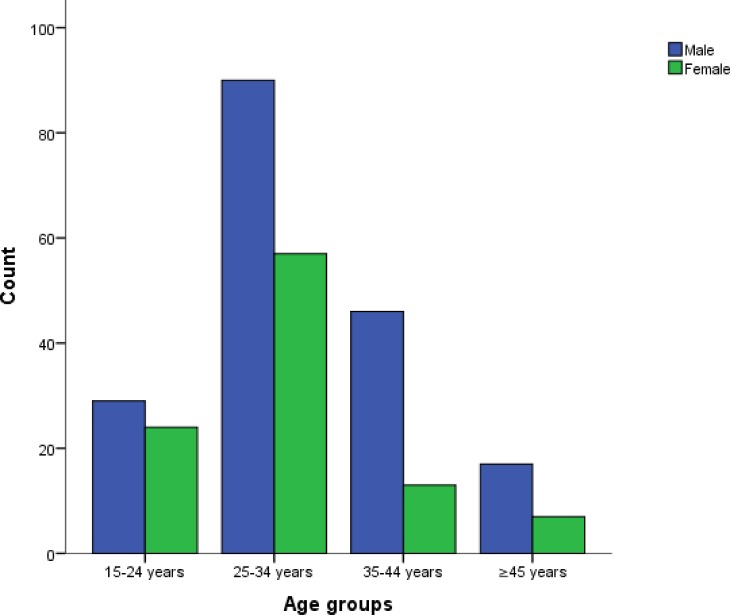
Age and gender distribution.